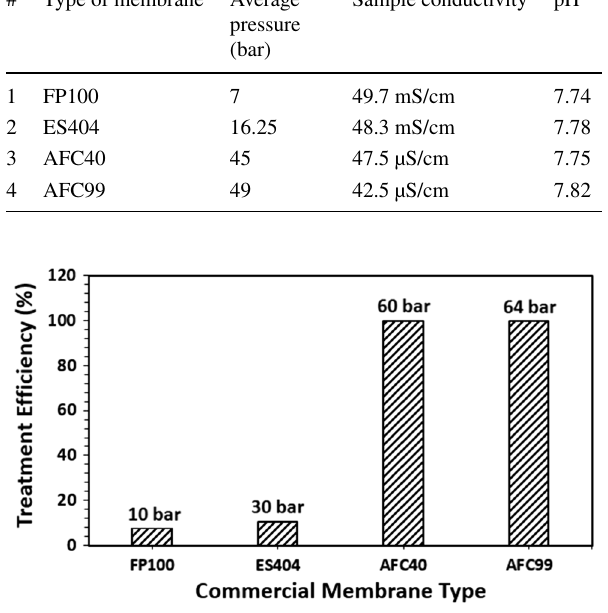
Fig. 15 The overall treatment efficiency of the four commercial mem- branes for the Red Sea